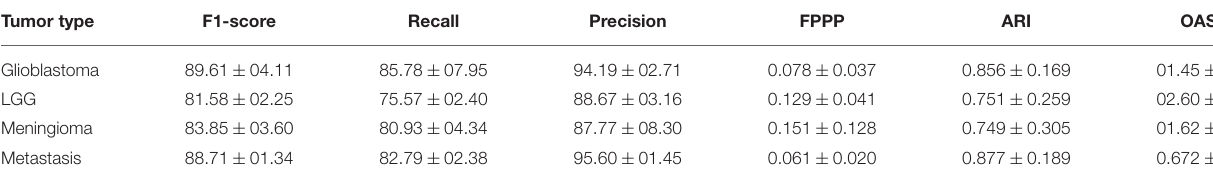
TABLE 8 | Instance-wise performance for each tumor type. Tumor type